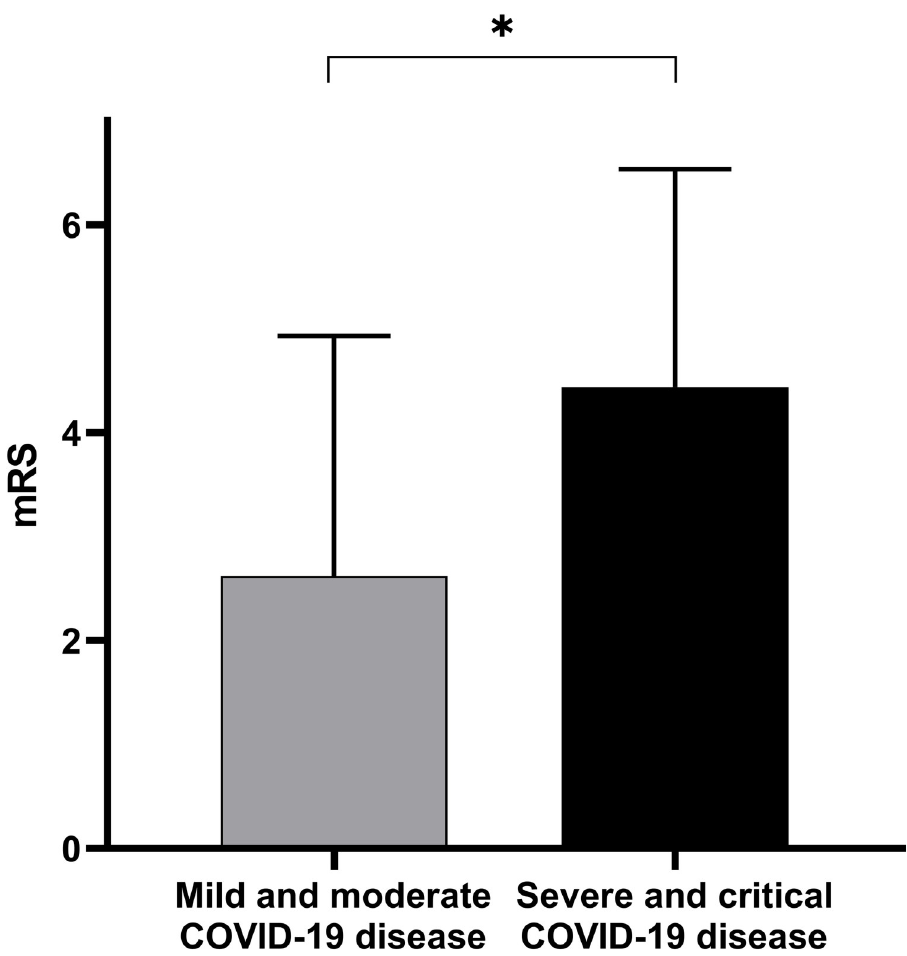
Fig 1. Relation of COVID-19 pneumonia and LVO in COVID-19 AIS patients. COVID-19 AIS patients with pneumonia more often had concomitant LVO (p = 0.139).